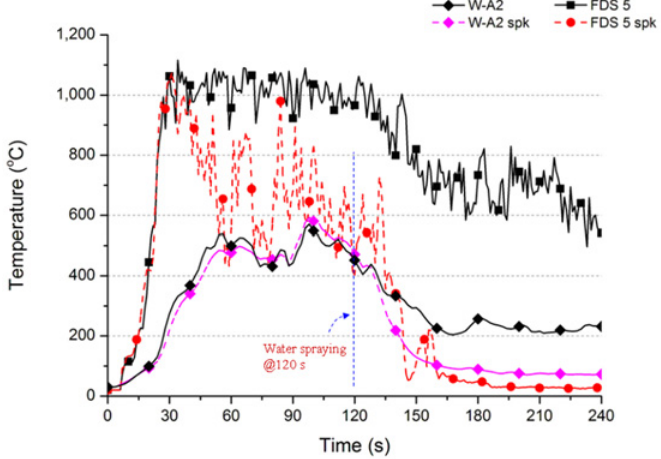
Fig 10. Temperature variation of experimental and numerical simulation cases (for FDS